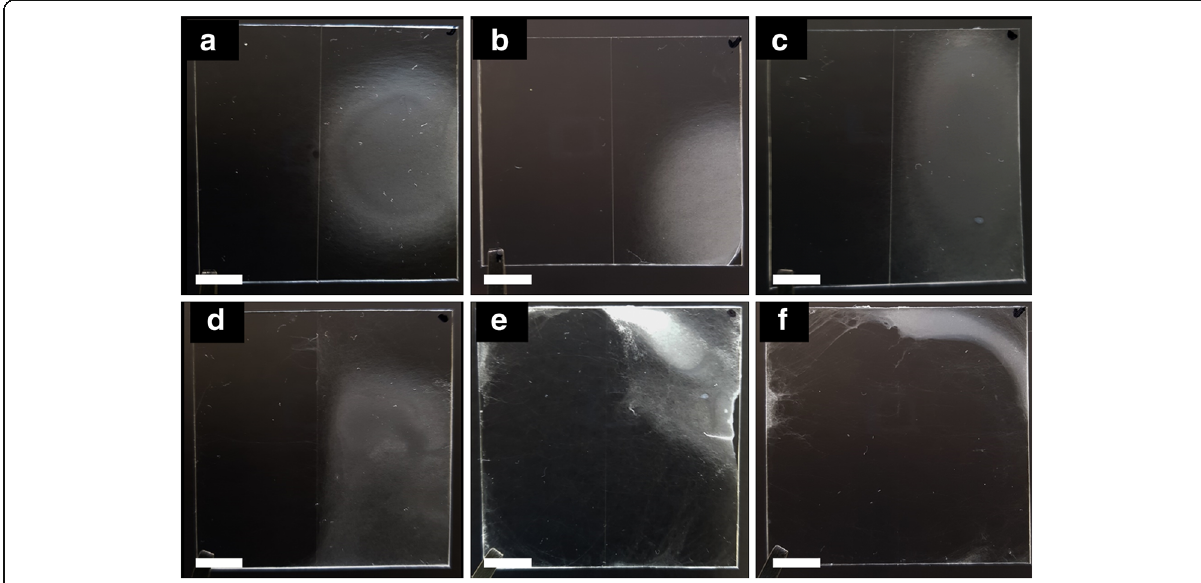
Fig. 5 Images of PU electrospun fiber on polymer substrate with hydrophilic (right) and hydrophobic (left) surface according to applied DC voltage for 2 min. a 6 kV. b 8 kV. c 10 kV. d 12 kV. e 14 kV. f 16 kV (scale bar: 10